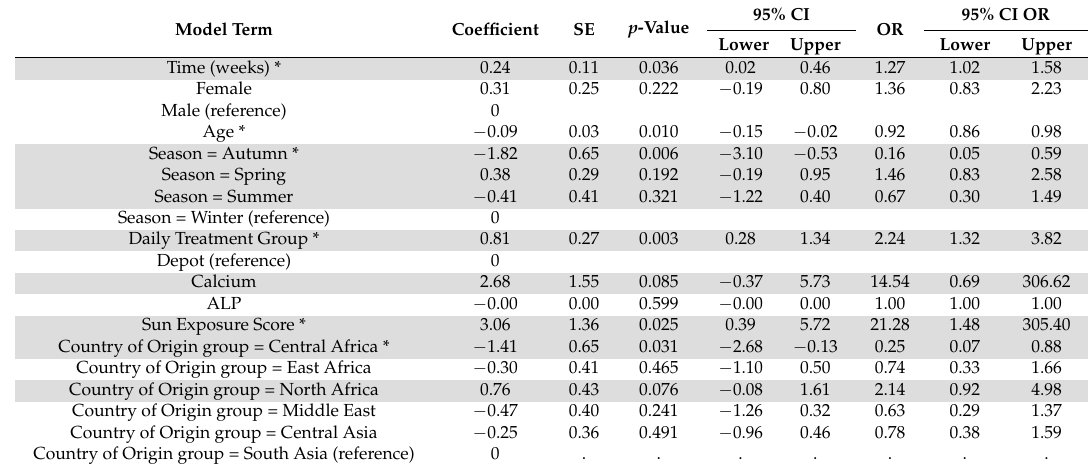
Table 6. GLMM Model 3 Parameter Estimates for meeting Vitamin D serum threshold (25(OH)D ≥ 78 nmol/L). Model